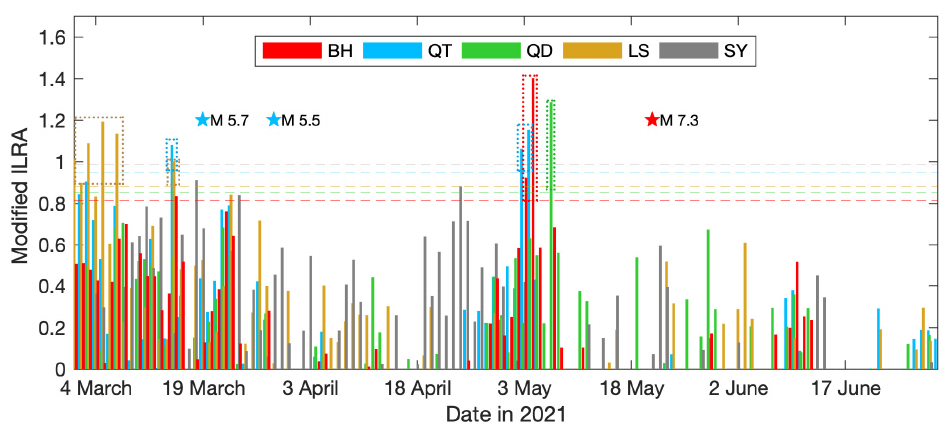
Figure 6. Time series of ILRA variations in different tectonic blocks from March to June in 2021. BH—Bayan Har block; QT—Qiangtang block; QD—Qaidam block; LS—Lhasa block; SY—Sichuan– Yunnan block. Colored dashed lines indicate the threshold (mean ILRA plus two standard deviations) in tectonic blocks with corresponding color. Colored dashed boxes indicate the parts exceeding the corresponding threshold. The red star indicates the day that the Madoi M 7.3 earthquake occurred, and the blue stars indicate two moderate earthquakes in Qiangtang block in March